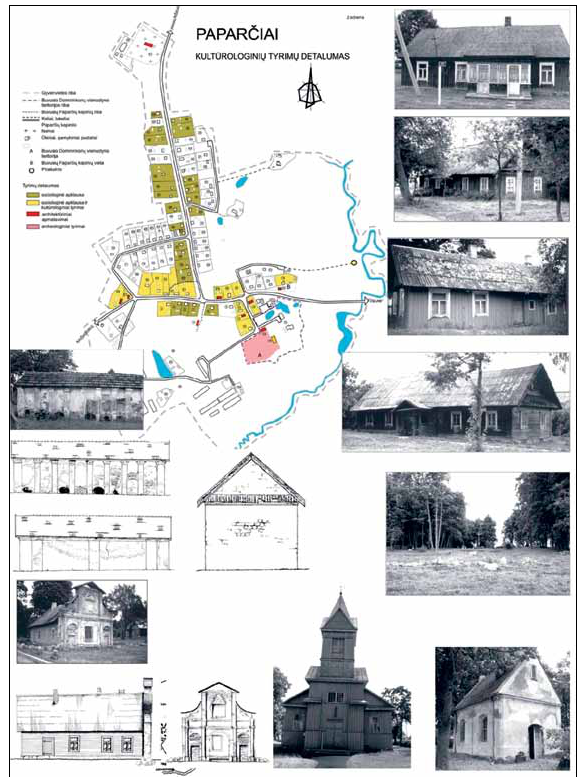
fig. 8. results of the Practice of architectural Measurement and Geodesy are presented to the local communities